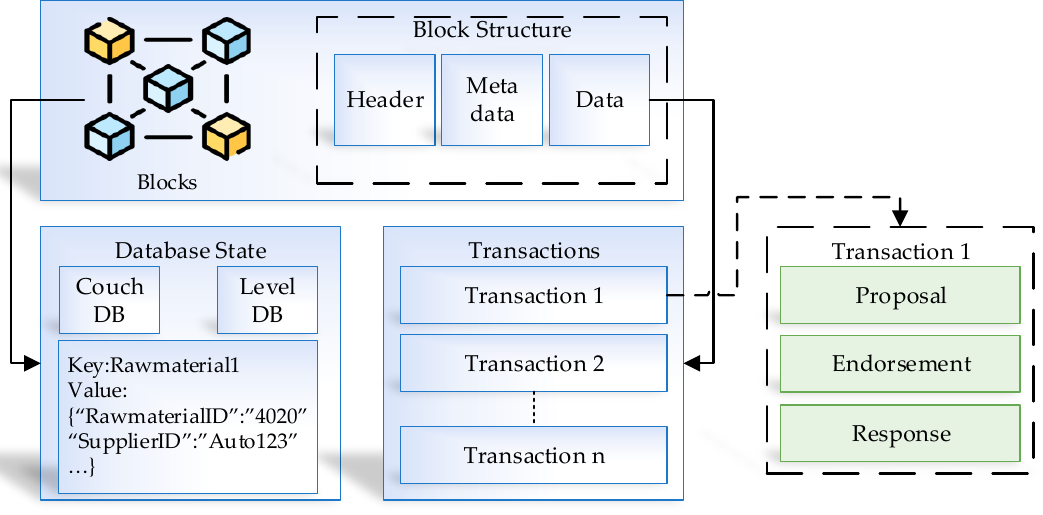
Figure 9. Ledger communication and the block transaction